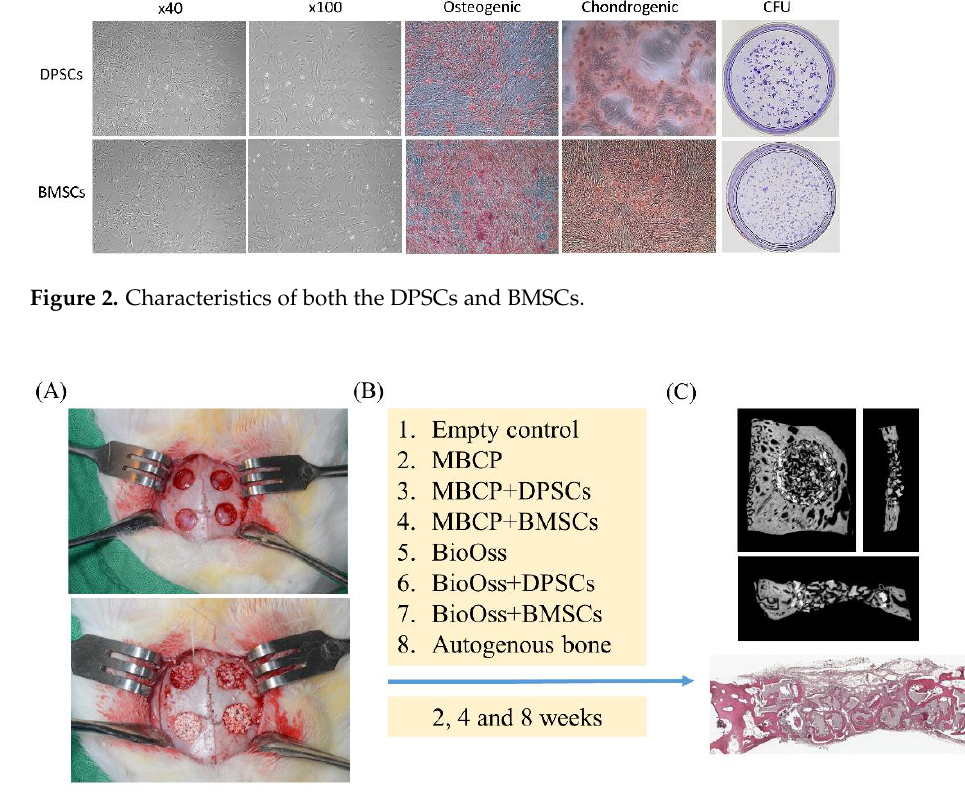
Figure 3. Schematic representation of the in vivo experiments was demonstrated. ( A ) A clinical photograph of the surgery and implantation of bone grafting materials for bone regeneration. Four circular bone defects measuring 6 mm in diameter were created using a trephine drill in surgical areas. ( B ) The bone defects were randomly allocated to eight experimental groups: empty control, MBCP, MBCP+DPSCs, MBCP+BMSCs, Bio-Oss, Bio-Oss+DPSCs, Bio-Oss+BMSCs, and autogenous bone. ( C ) Micro-CT and histological analysis.